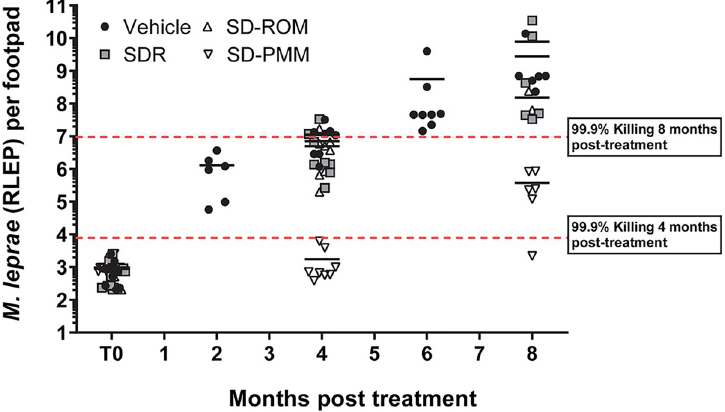
Fig 2. Early and late efficacy of single dose PEP regimens against M . leprae . Athymic nude mice were infected in both hind footpads with 6 x10 3 M . leprae . Mice were treated with single dose rifampin (SDR), single dose ROM (rifampin, ofloxacin, minocycline), or single dose PMM (rifapentine, moxifloxacin, minocycline). M . leprae were enumerated by RLEP qPCR at two, four, six, and eight months post treatment. Bars represent the mean for each group. A regression analysis was calculated to determine the expected RLEP value if 99.9% of the bacilli were killed after the administration of the single dose regimen (r 2 = 0.933). The 99.9% kill line at 4 months was 7.94 x 10 3 bacilli, and the 99.9% kill line at 8 months was 9.55 x 10 6